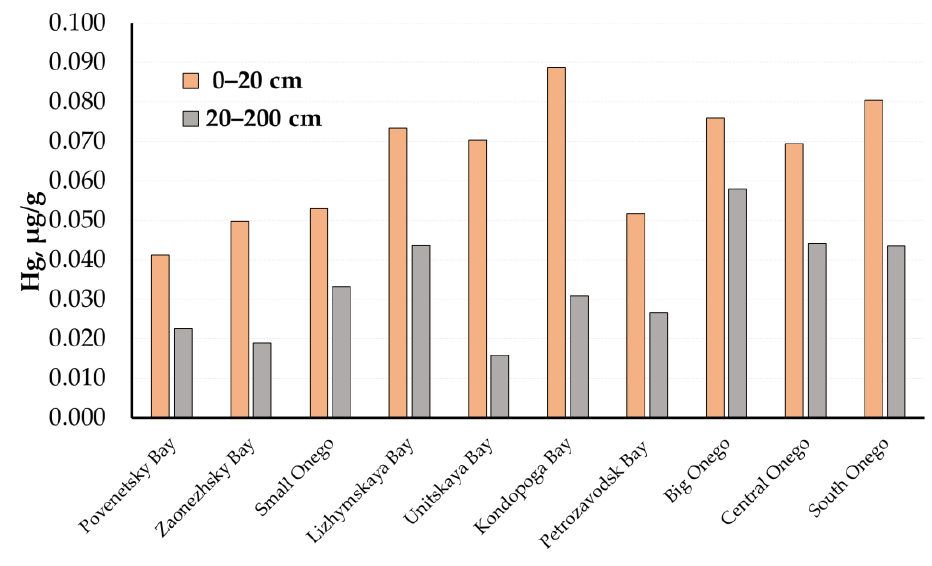
Figure 6. Mercury content in the bottom sediments of the different areas of Lake Onego.